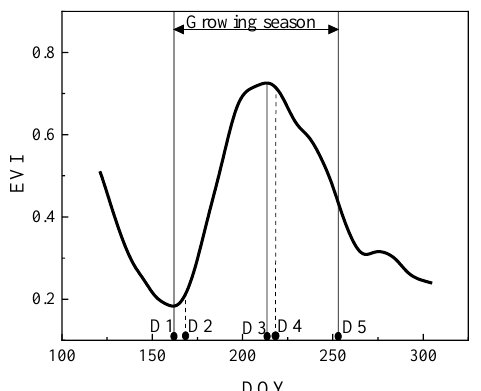
Figure 5. Five crop phenological periods. D 1 is the sowing period; D 2 is the emergence period; D 3 is the heading period; D 4 is the anthesis period; D 5 is the maturity period.